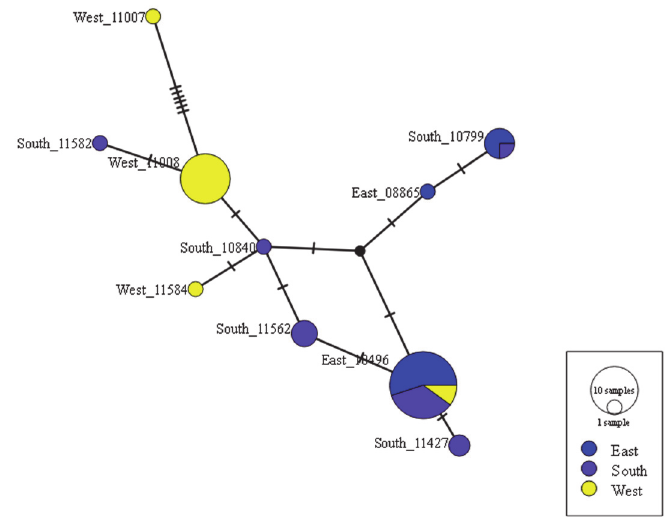
Figure 3. Median joining network-based mtDNA control region sequence haplotypes of 45 finless porpoises, including sequences from East, South, and West Seas. Aligned sequences were 473 bp long. Circle color indicates the region: dark blue, East Sea; purple, South Sea; yellow, West Sea. Table 4. Summary of the mtDNA sequence variability for populations of N. phocaenoides